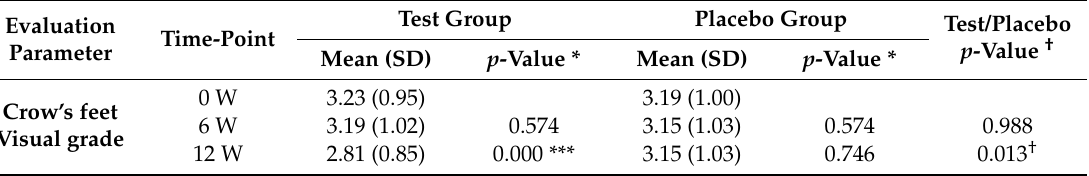
Table 5. Visual assessment of crow’s feet score by dermatologists.